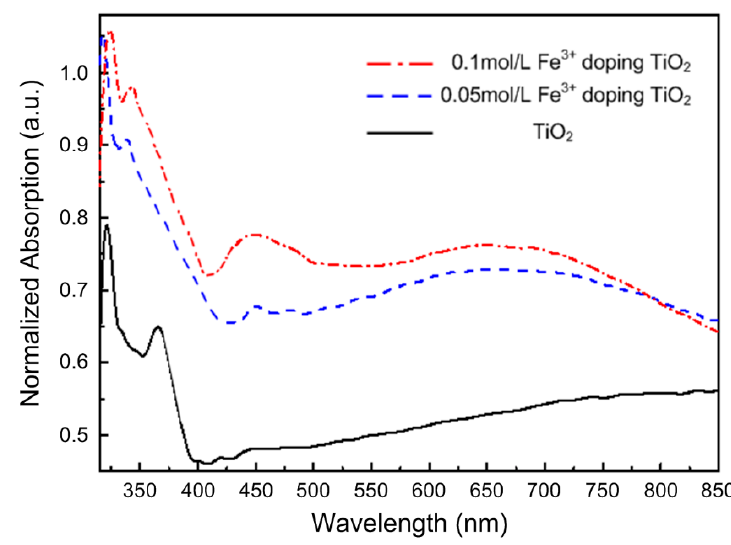
Figure 6. UV-Vis absorption spectra of pure and Fe 3+ doped TiO 2 NTAs.